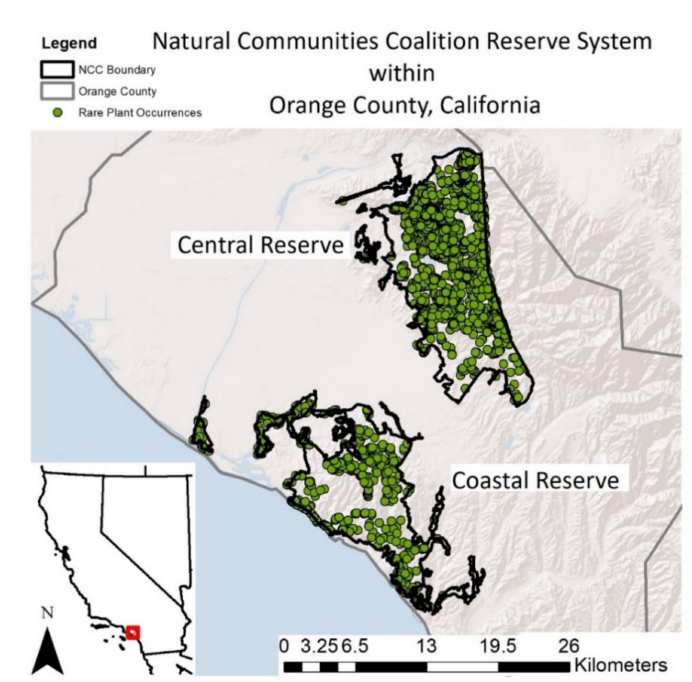
Figure 1. Rare plants occur throughout most of the Natural Communities Coalition Reserve System located in Orange County, California. Each point on this map indicates a unique rare plant occurrence record ( N =